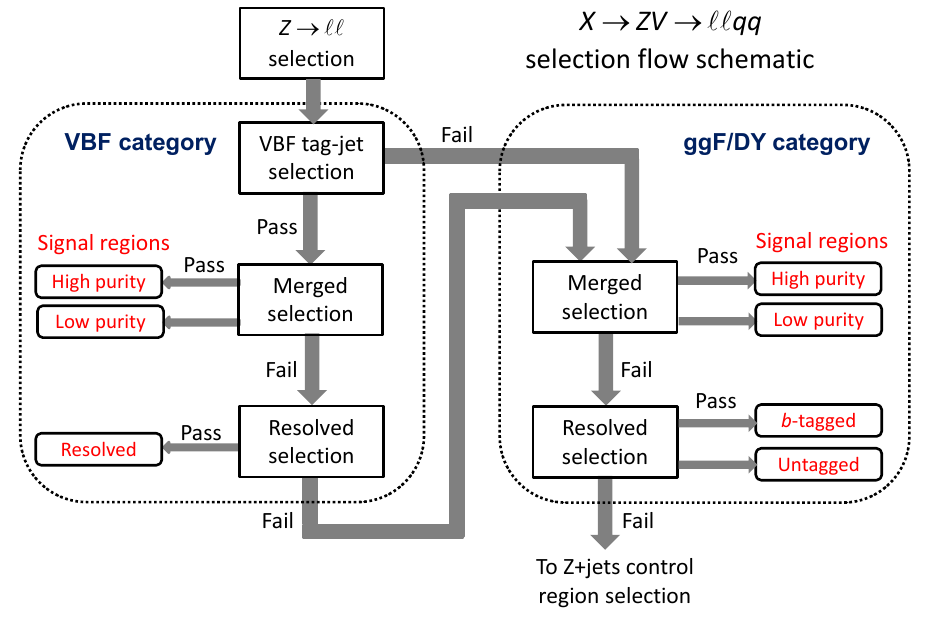
Figure 2 . Illustration of the selection (cid:13)ow and seven signal regions of the X The VBF category is targeted for VBF production whereas the ggF/DY category is for the rest, including events failing the selection for the VBF category. The selected VBF tag-jets are removed from the subsequent selection for the VBF category. However, if an event fails to be selected for the VBF category, these jets are kept for the ggF/DY category selection. The H utilises all seven signal regions and the W 0 b -tagged and untagged regions of the ggF/DY category. The G KK selection, so it has only four signal